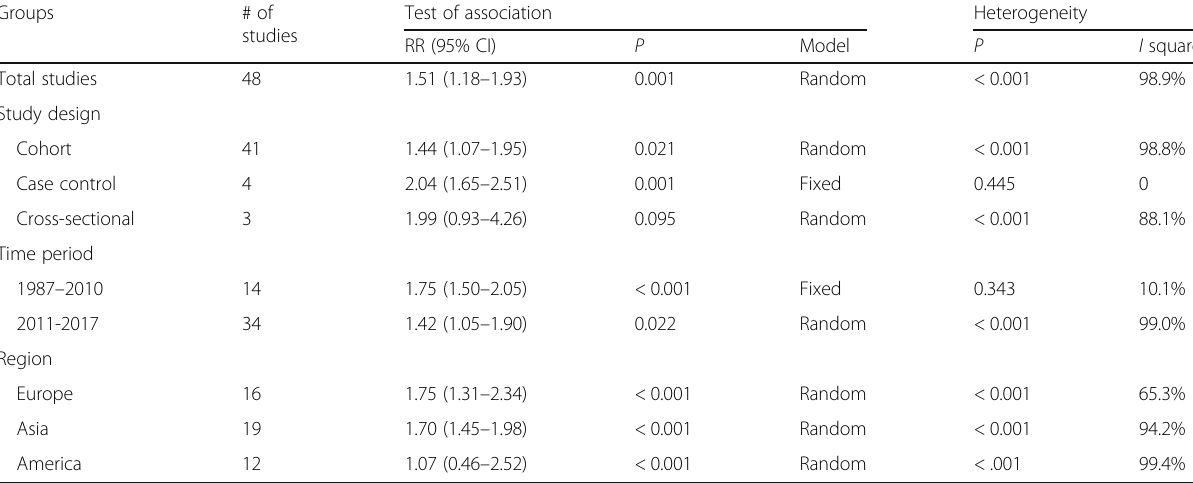
Table 3 Summary of meta-analysis results and subgroups analysis